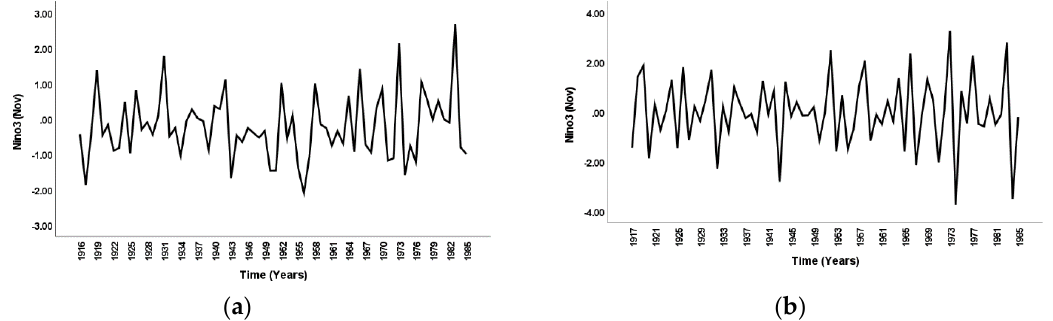
Figure 4. Climate Indices Nino3 Nov for Albany: ( a ) before differencing and ( b ) after differencing.